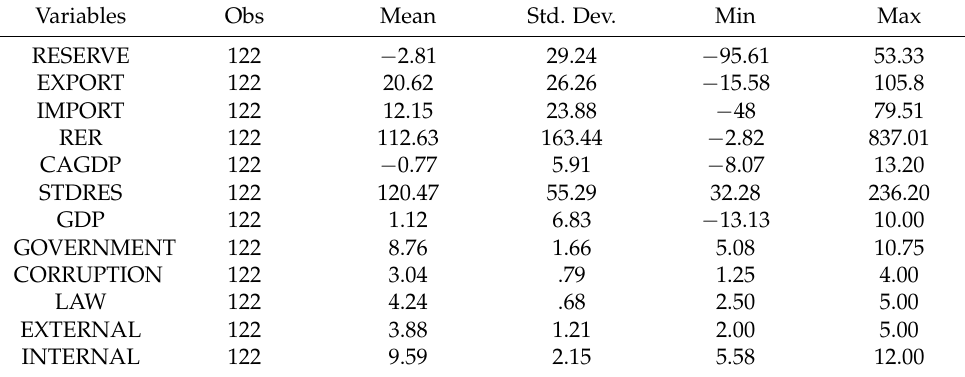
Table Panel C: Summary of descriptive statistics for the crisis period,